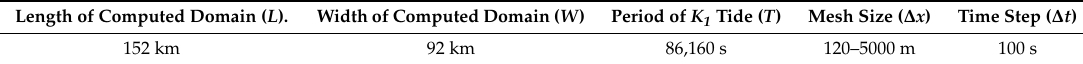
Table 1. Parameters used in the Dongsha ocean circulations modeling. Length of Computed Domain ( L